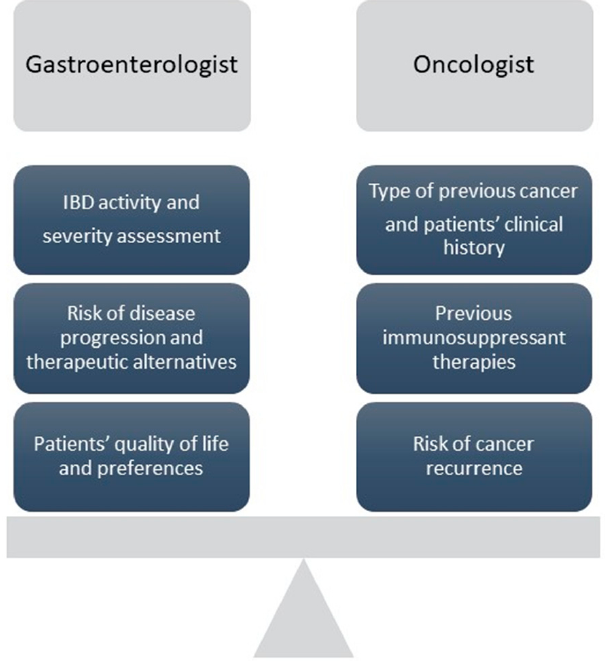
Figure 2. Balanced evaluation of clinical factors to be considered by gastroenterologist and